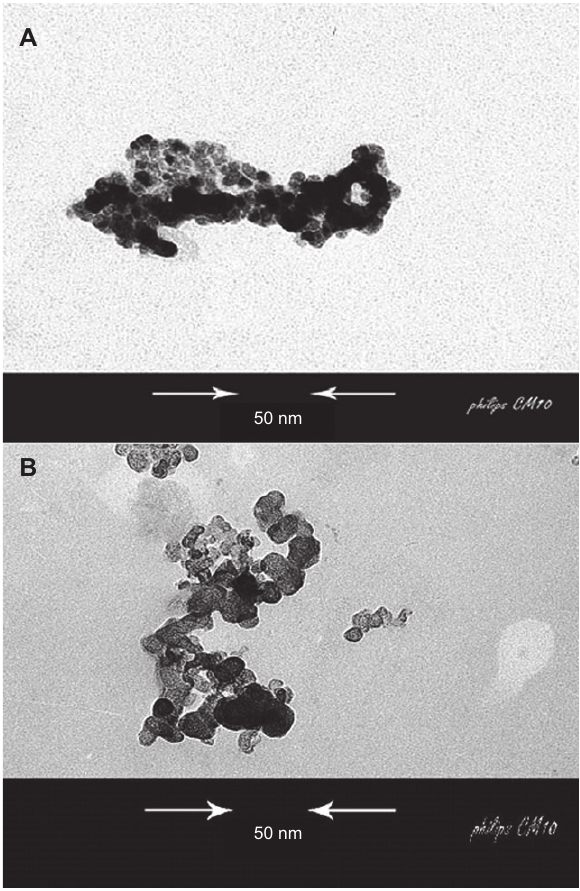
Figure 3 TEM images of the PbS nanoparticles synthesized with (A) 0.5 and (B) 1 m of thiophenol.